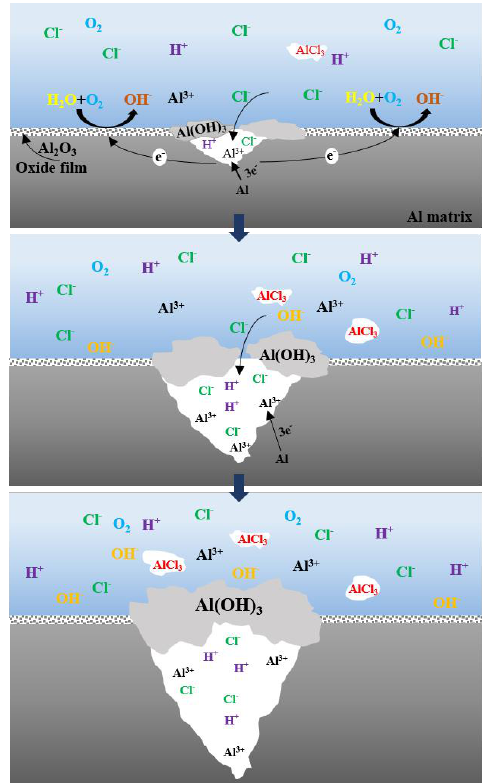
Figure 9. The expansion mechanism of the pits.